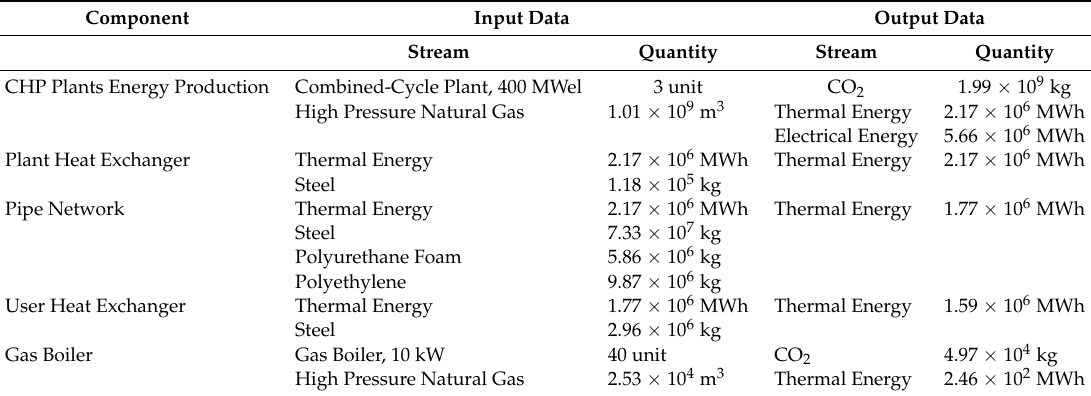
Table 2. Material and energy stream